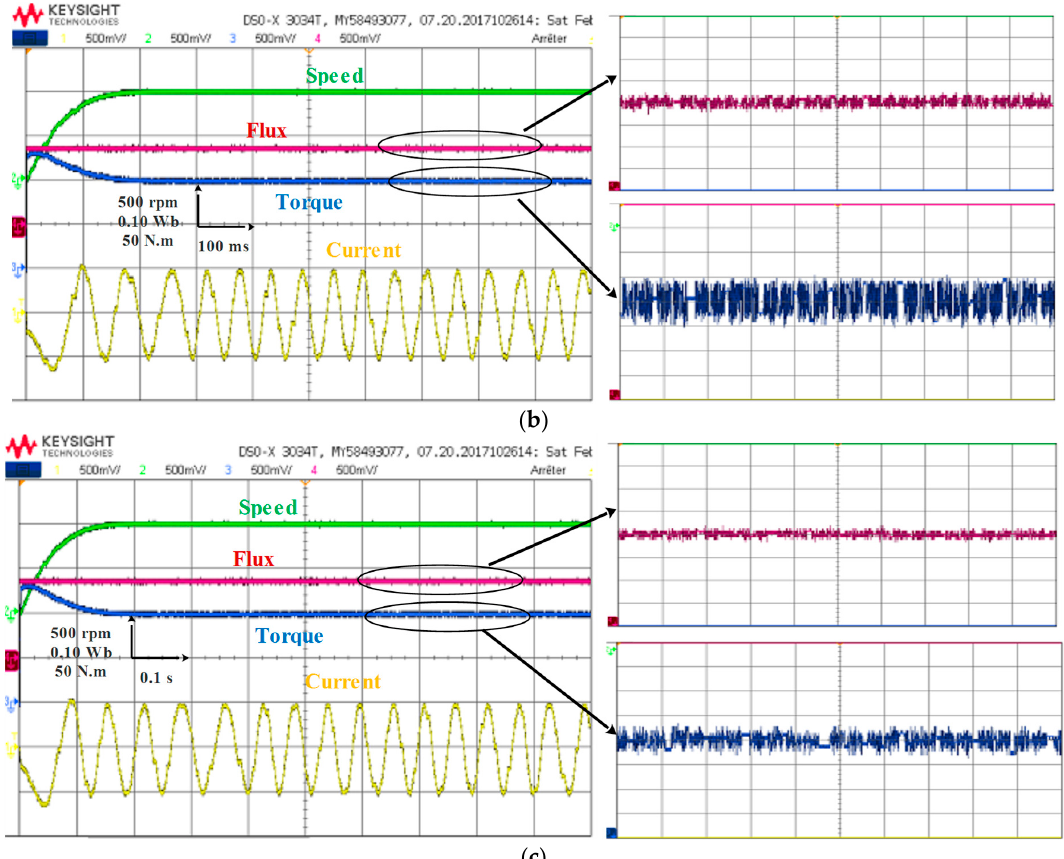
Figure 25. Steady-state analysis with different techniques ( a ) DTC; ( b ) FDTC; ( c ) MPDTC.